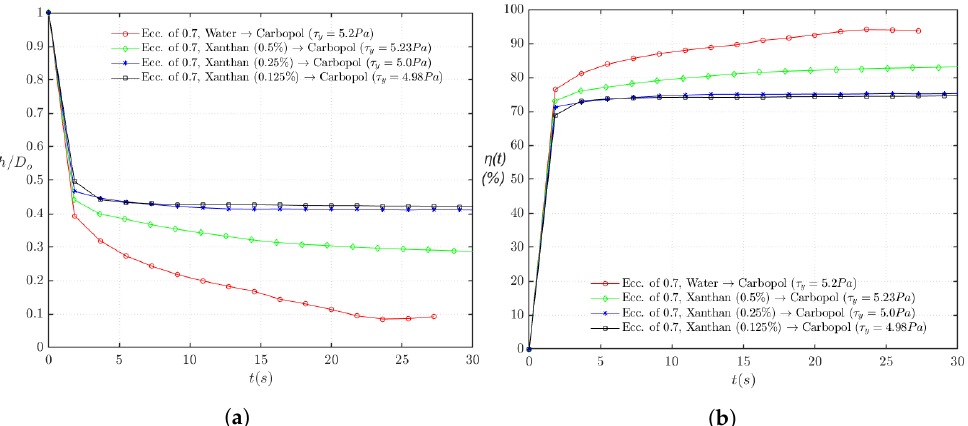
Figure 10. Displacement performance: ( a ) Average measured thickness of the Carbopol layer in the partially eccentric annulus ( e = 0.7) and ( b ) computed volumetric efficiency in the partially eccentric annulus ( e =